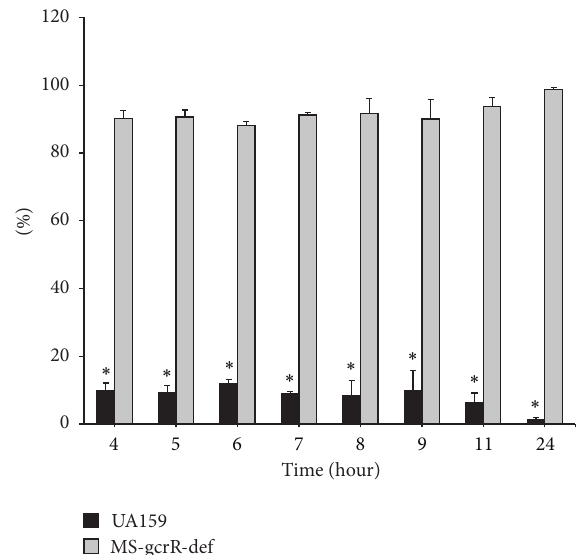
Figure 5: The coculture bacteria were harvested and used to extract RNA; expression of biofilm-associated genes was examined by quantifying the gcrR gene using real-time RT-PCR. ∗ Significant difference observed from comparison of the two groups at every testing time ( 𝑃 < 0.05 ).